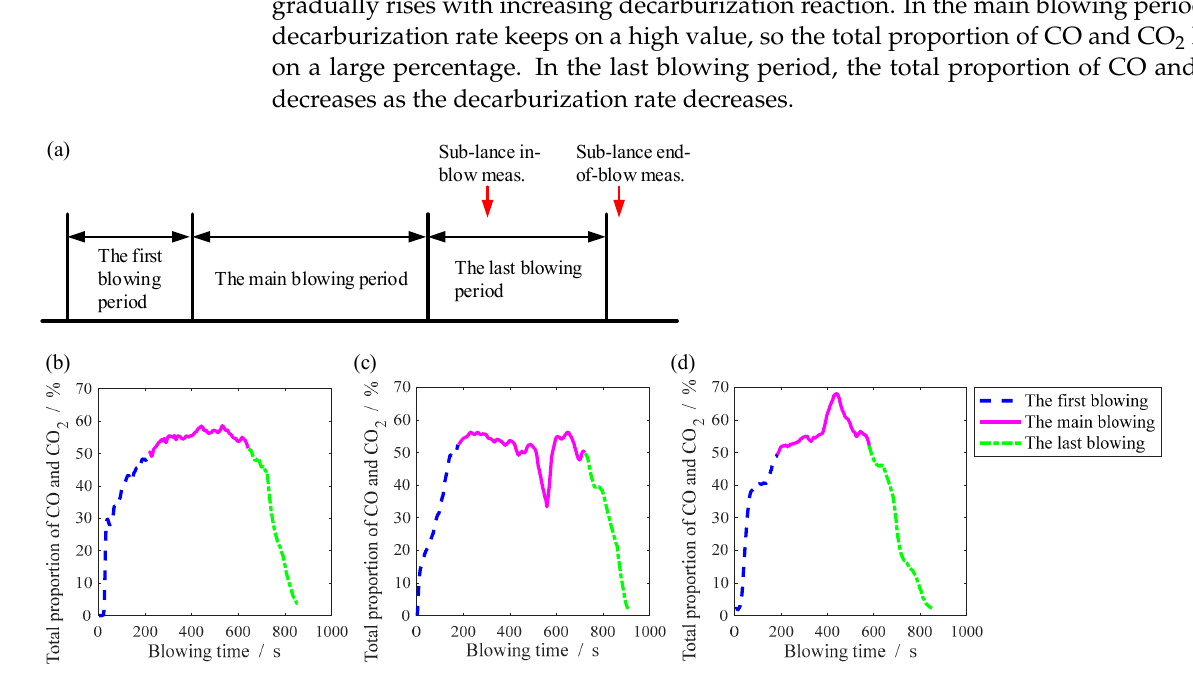
Figure 2. ( a ) The schematic representation of different blowing periods; ( b ) the off-gas compositions of a normal batch; ( c ) the off-gas compositions of a splashing batch; ( d ) the off-gas compositions of a drying batch.